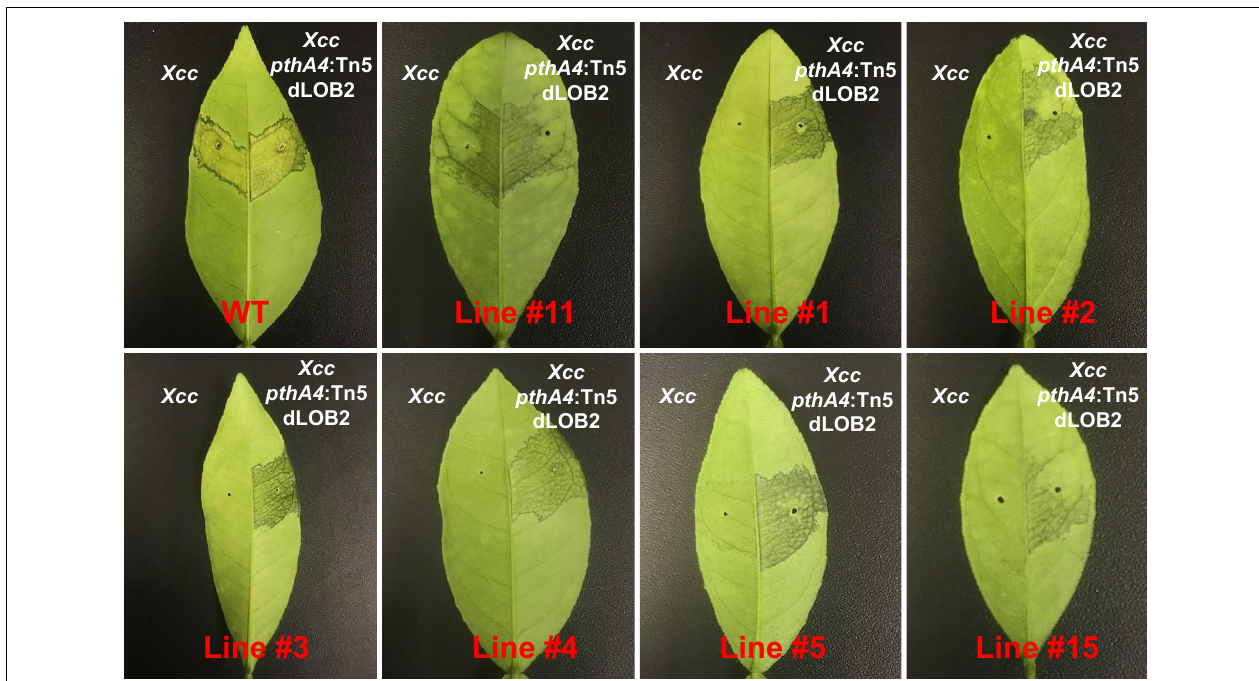
FIGURE 5 | Biallelic mutants of the EBE region of CsLOB1 of Hamlin sweet orange are resistant to Xcc. Xcc inoculation assay was conducted using fully expanded young leaves. Line #11 is a heterozygous mutant; other lines are biallelic mutants. For each line, left half of the tested leaf was syringe inoculated with wild-type Xcc (10 8 CFU/ml); the right half of the tested leaf was inoculated with Xcc pthA4 :Tn5 carrying designer TAL effector dLOB2 (10 8 CFU/ml). Pictures were taken at 8 days post inoculation.